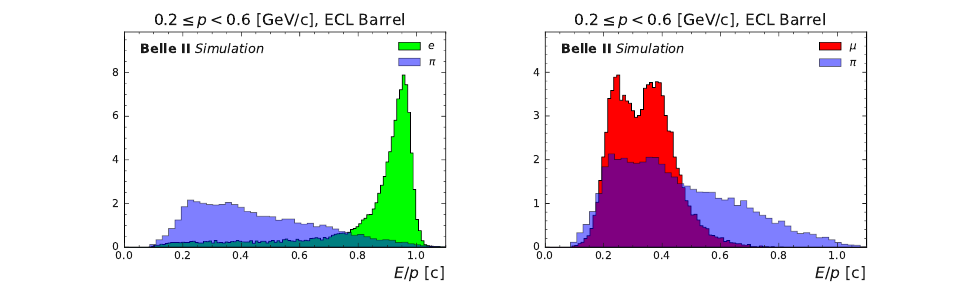
Figure 2. Distribution of E / p for simulated single particle candidates: e ± (green), µ ± (red) and π ± (blue) for 0 . 2 ≤ p < 0 . 6 GeV / c in the ECL barrel region (defined by the polar angle range 0 . 56 ≤ θ < 2 . 24